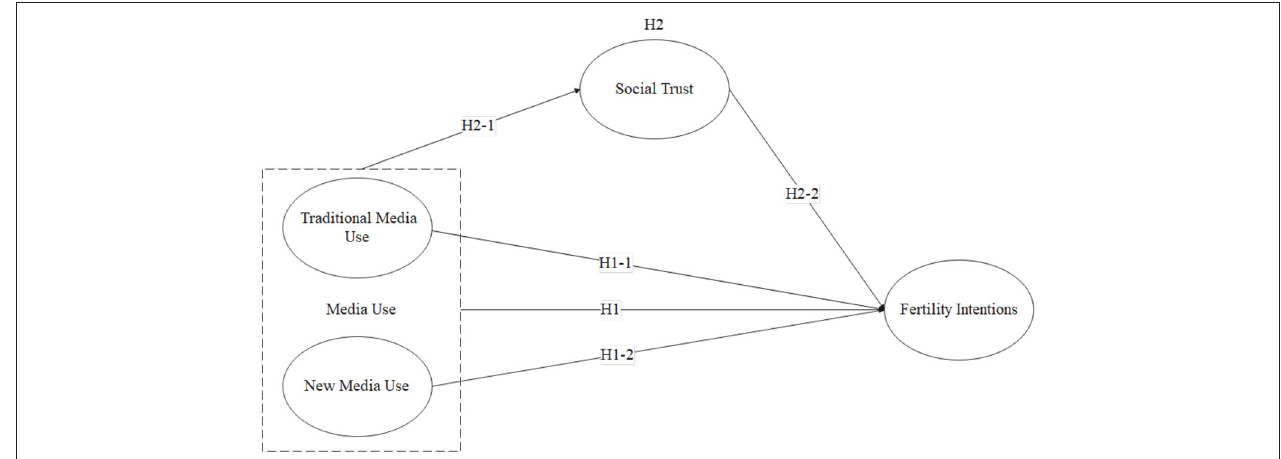
FIGURE 1 | Hypothesized model.